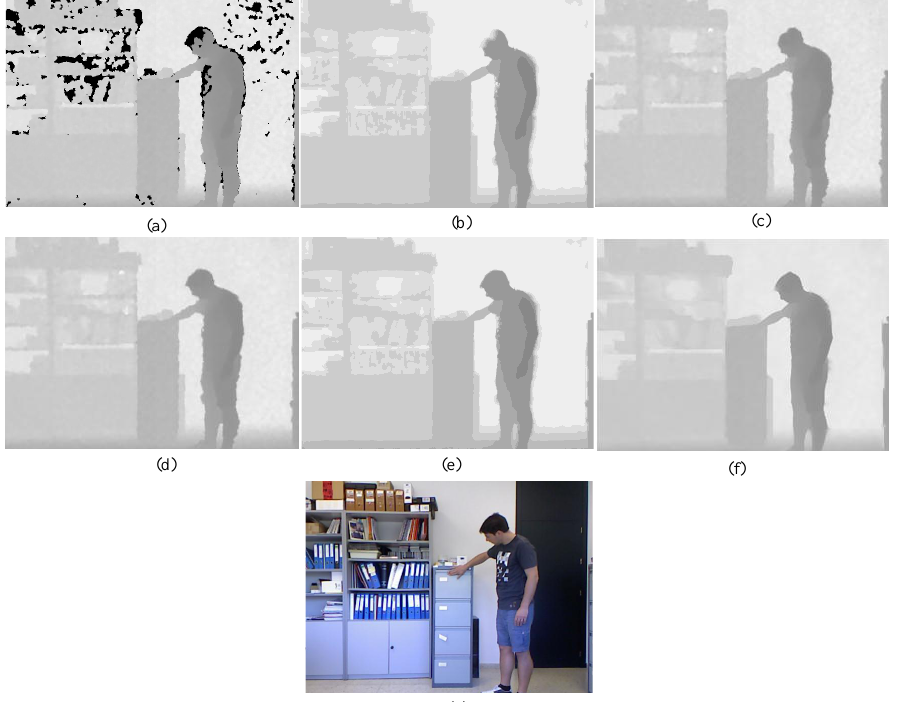
Figure 11. Experimental Results: ( a ) Original; ( b ) JBF; ( c ) FMI;( d ) GFMI; ( e ) GFMIGF; ( f ) Proposed method; ( g ) Color